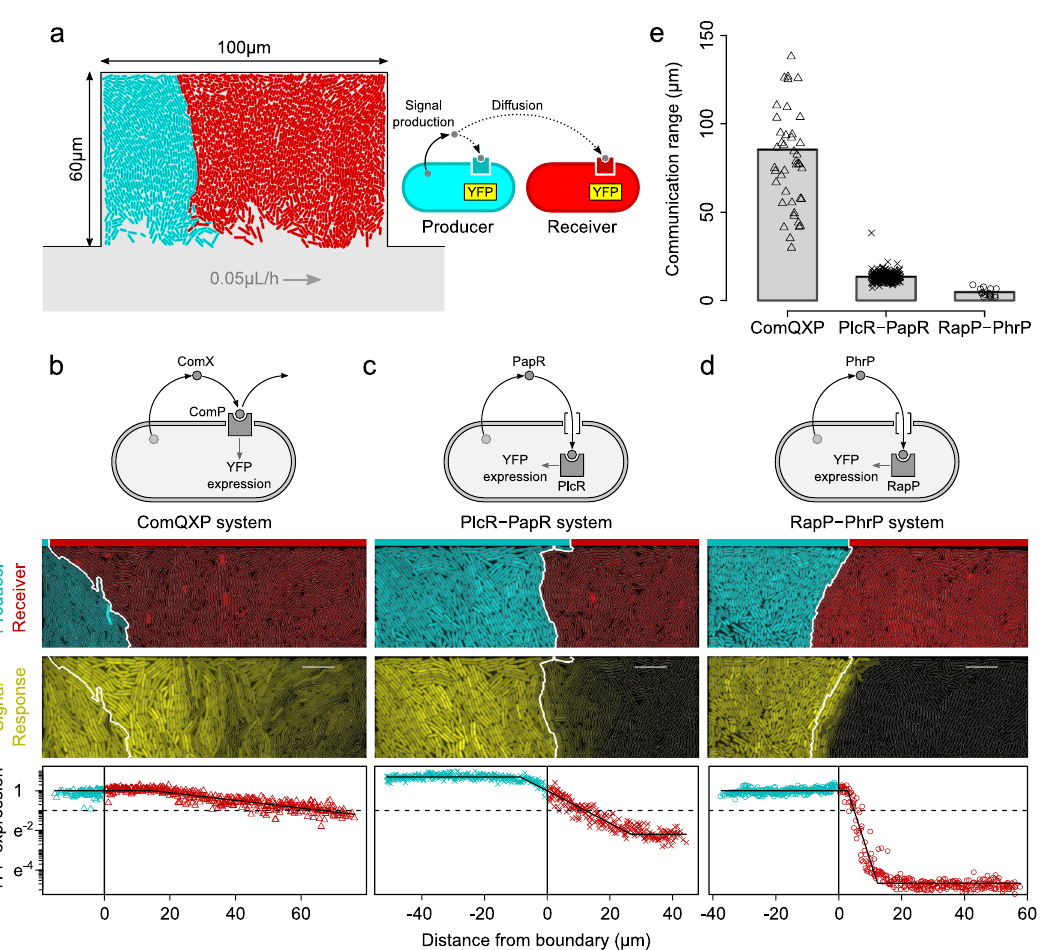
Fig. 2 Communication range in absorbing and nonabsorbing quorum-sensing systems. a Representation of growth chamber with signal-producing (blue, marked by constitutive BFP) and signal-receiving cells (red, marked by constitutive RFP). Role of producers and receivers is illustrated on the right. Communication ranges in b ComQXP system, c PlcR-PapR system, and d RapP-PhrP system, from top to bottom: schematic depiction of quorum-sensing system (see also Supplementary Fig. 9), microscopy image with the distribution of signal producers (blue) and receivers (red) in micro fl uidic chamber, microscopy image of signal response (YFP expression; scale bar = 10 μ m), and signal response as a function of the distance of cells to the boundary of signal producers (thick white line in microscopy images). Signal-producing cells are marked in blue with negative distances, while receivers are marked in red with positive distances. Black line marks best- fi t curves (see “ Methods ” ). Horizontal dotted line shows one order of magnitude reduction in signal response (on natural log scale). Solid vertical line in shows boundary. e Communication ranges of ComQXP, PlcR-PapR, and RapP-PhrP quorum-sensing ¼ 141 : 98 ; p < 10 (cid:3) 16 ). Source data are provided in Supplementary Data systems ( χ 2 ð 2 Þ